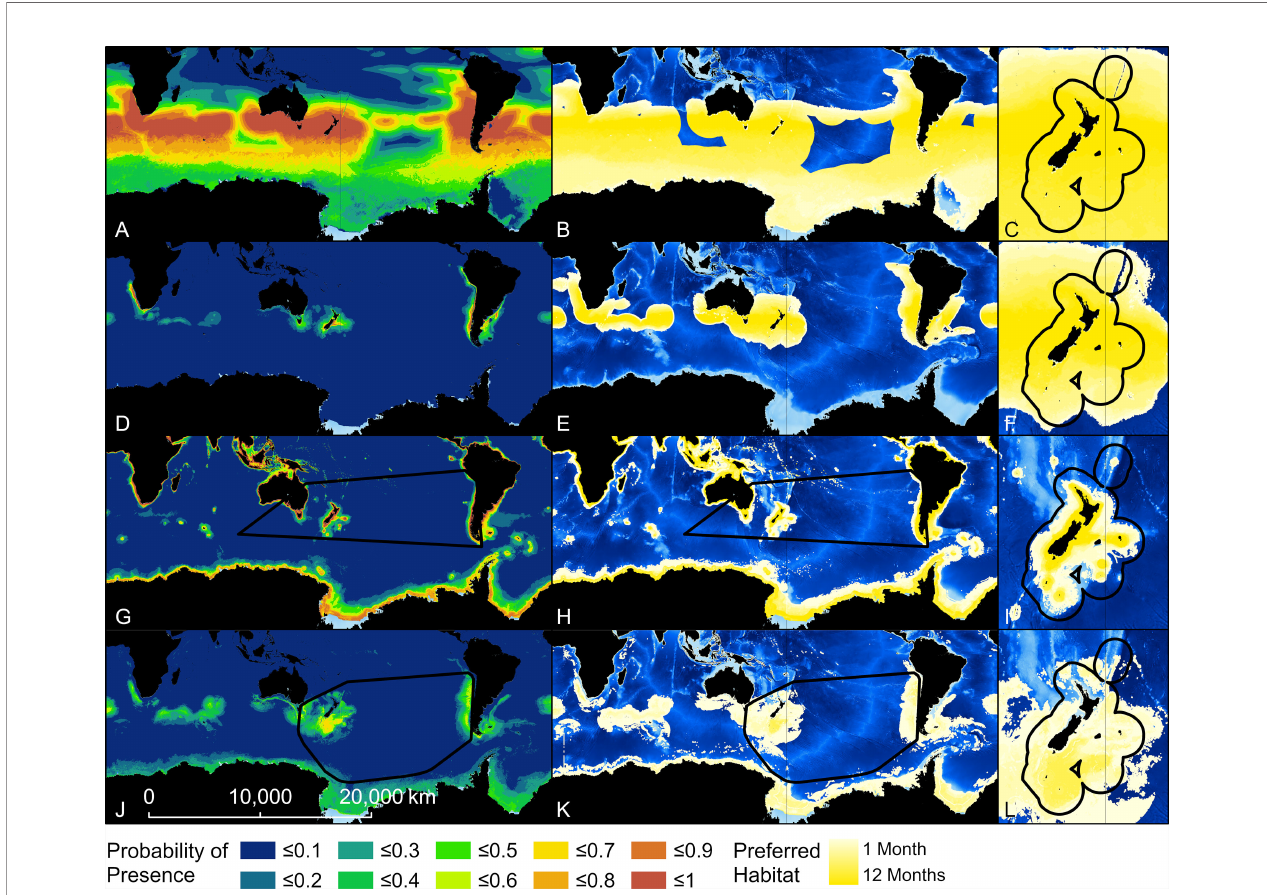
FIGURE 3 | Probability of presence and habitat of Buller ’ s albatross predicted by four models. Top two rows show results from two Relative Environmental Suitability models [one fi t with values obtained from the monthly 50% kernel density contours from geolocation data (RES KERN , A – C )], and one fi t with values from the literature and expert opinion [RES LIT , (D – F) ]. Bottom two rows show results from two Boosted Regression Tree models (one fi t with opportunistic sightings data [BRT OS , (G – I) ], and one fi t with geolocation data [BRT GL , (J – L) ]. Black boundaries indicate the minimum Convex Hull (G, H, J, K) or New Zealand ’ s Exclusive Economic Zone (C, F, I, L) and habitat is colour-scaled from 1 to 12 indicating the number of months each cell was classi fi ed as